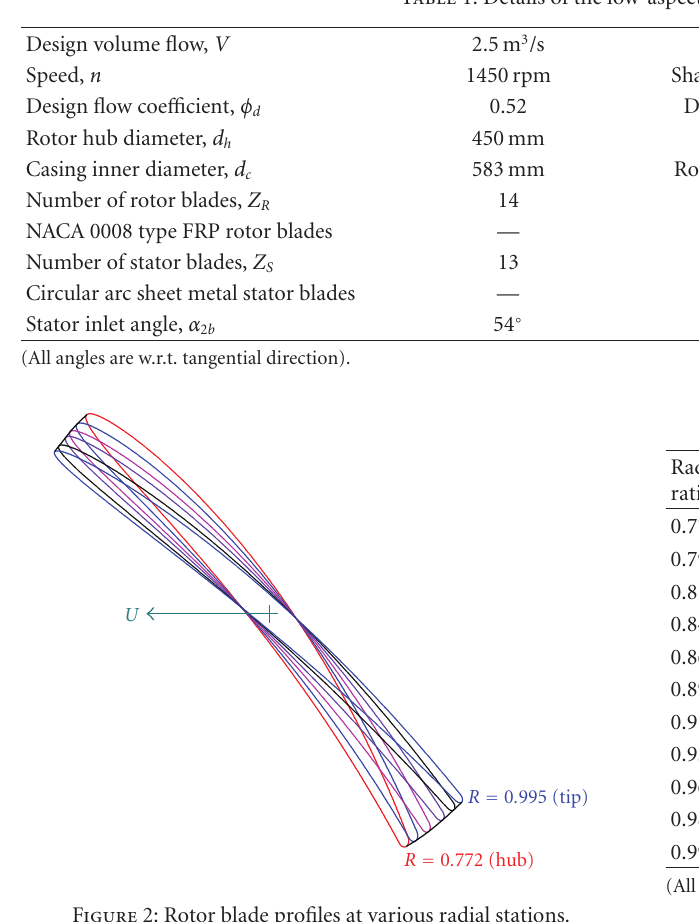
given in Table 2. Rotor blade profiles at alternate radial sta- tions from rotor hub to tip are shown in Figure